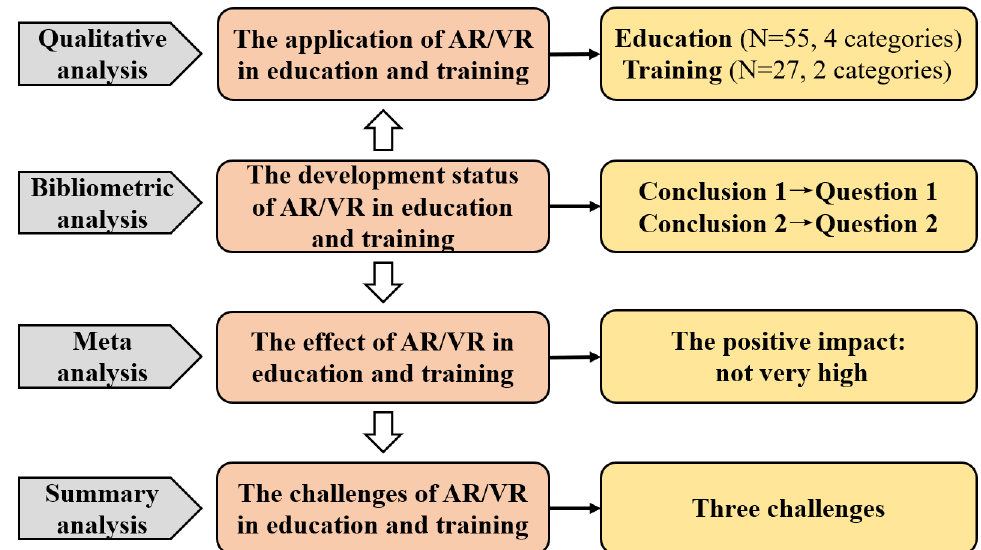
Figure 4. Flow chart of analysis based on the four methods.